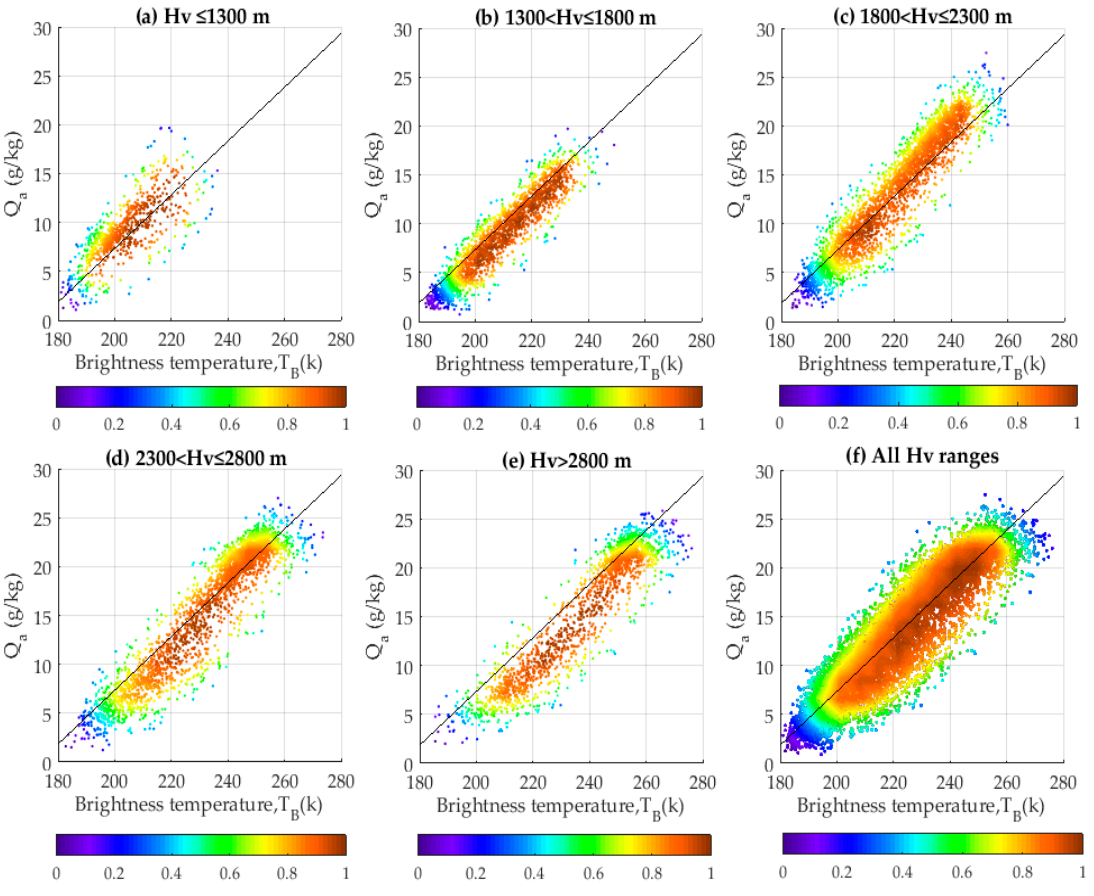
Figure 3. Scatter diagrams showing the relationship between 𝑇 (cid:3003),(cid:2870)(cid:2871)(cid:3023) , 𝑄 (cid:3028) , and 𝐻 (cid:3049) , using the Sample 1 data. ( a ) For H v ≤ 1300 m; ( b ) for 1300 m < H v ≤ 1800 m; ( c ) for 1800 m < H v ≤ 2300 m; ( d ) for 2300 m data. ( a ) For 𝐻 (cid:3049) ≤ 1300 m; ( b ) for 1300 m < 𝐻 (cid:3049) ≤ 1800 m; ( c ) for 1800 m < 𝐻 (cid:3049) ≤ 2300 m; ( d ) for 2300 m < H v ≤ 2800 m; ( e ) for H v > 2800 m; and ( f ) for all H v ranges. Each figure shows a linear regression < 𝐻 (cid:3049) ≤ 2800 m; ( e ) for 𝐻 (cid:3049) > 2800 m; and ( f ) for all 𝐻 (cid:3049) ranges. Each figure shows a linear regression line line calculated using all H v range data. Color depth indicates the density of calculated using all 𝐻 (cid:3049) range data. Color depth indicates the density of data.